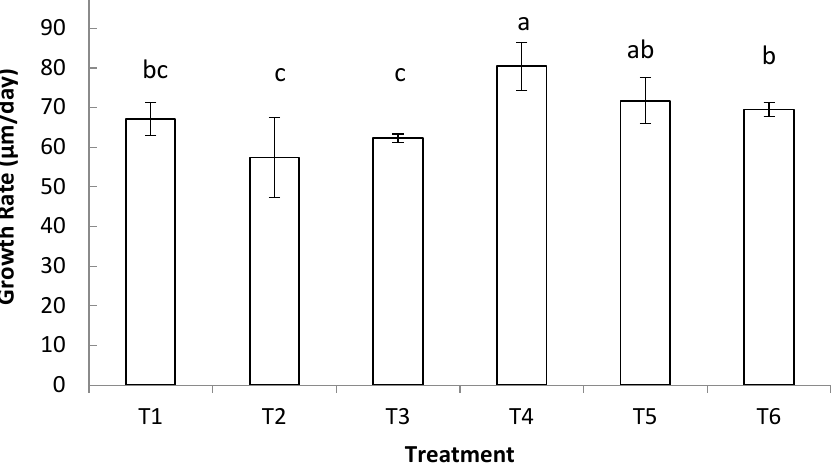
Figure 2. Daily growth rate of post-set sunray venus clams ( Macrocallista nimbosa ) fed live microalgae diets. Different letters indicate significant differences among the treatments (one-way ANOVA, α = 0.05, a > b > c > d). Each bar represents the mean ± SD of three replicates.